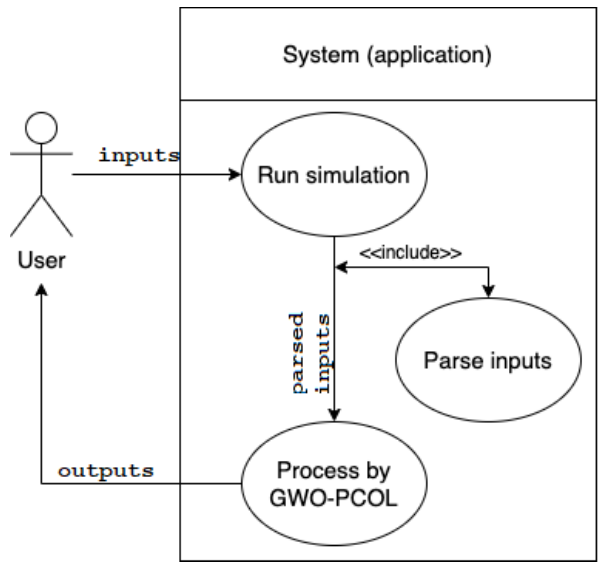
Figure 1. The use case diagram of the